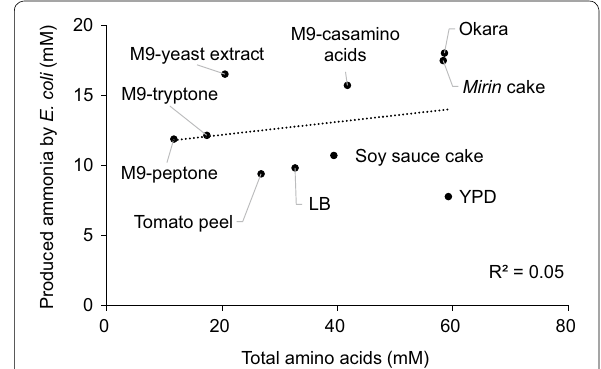
Fig. 1 Relationship between ammonia production and total amino acids. Ammonia was produced by E. coli DH10B from four food by-products and six media containing amino acids. E. coli strains were initially grown overnight in M9-yeast extract, then the cells were washed with sterile water and inoculated into 2 mL of pretreated food by-products or semisynthesized medium to a final OD 600 of 0.5. After incubation at 37 °C for 26.5 h with shaking, the concentrations of ammonia in the supernatants were measured. The data of ammonia concentration are represented as the mean values (n and total amino acid concentration in the medium was determined at n 1 =